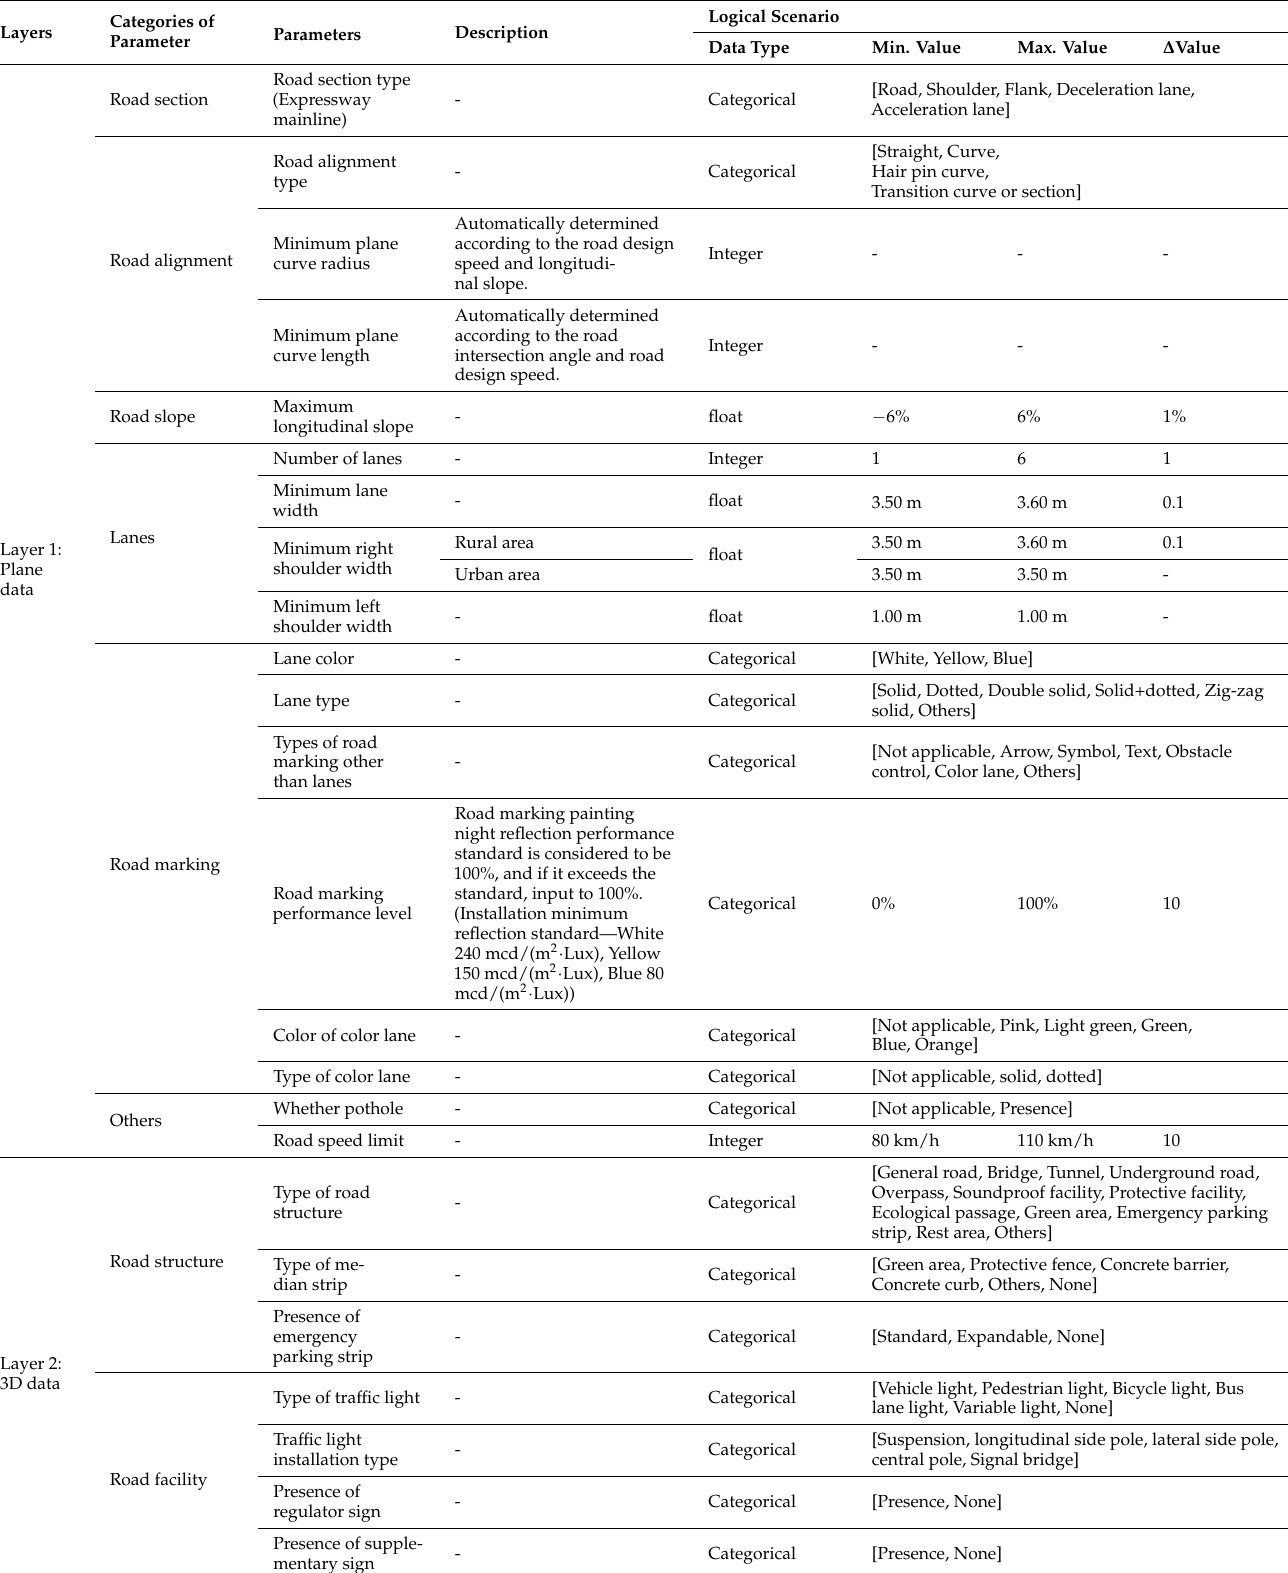
Table 3. Logical scenario generation